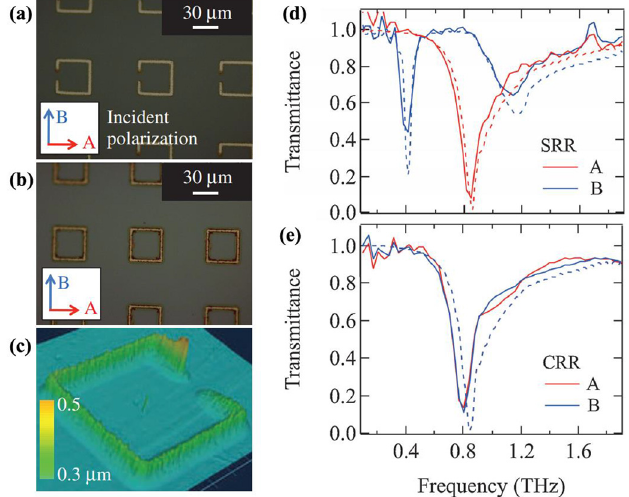
Fig. 4. Microscope photographs of (a) SRRs and (b) CRRs printed on Si substrates, and (c) topographic image of SRRs. Transmission spectra of (d) SRRs and (e) CRRs for incident polarizations [64]. Reproduced with permission from K. Takano et al., Appl. Phys. Express 3 , 016701 (2009). Copyright 2009 The Japan Society